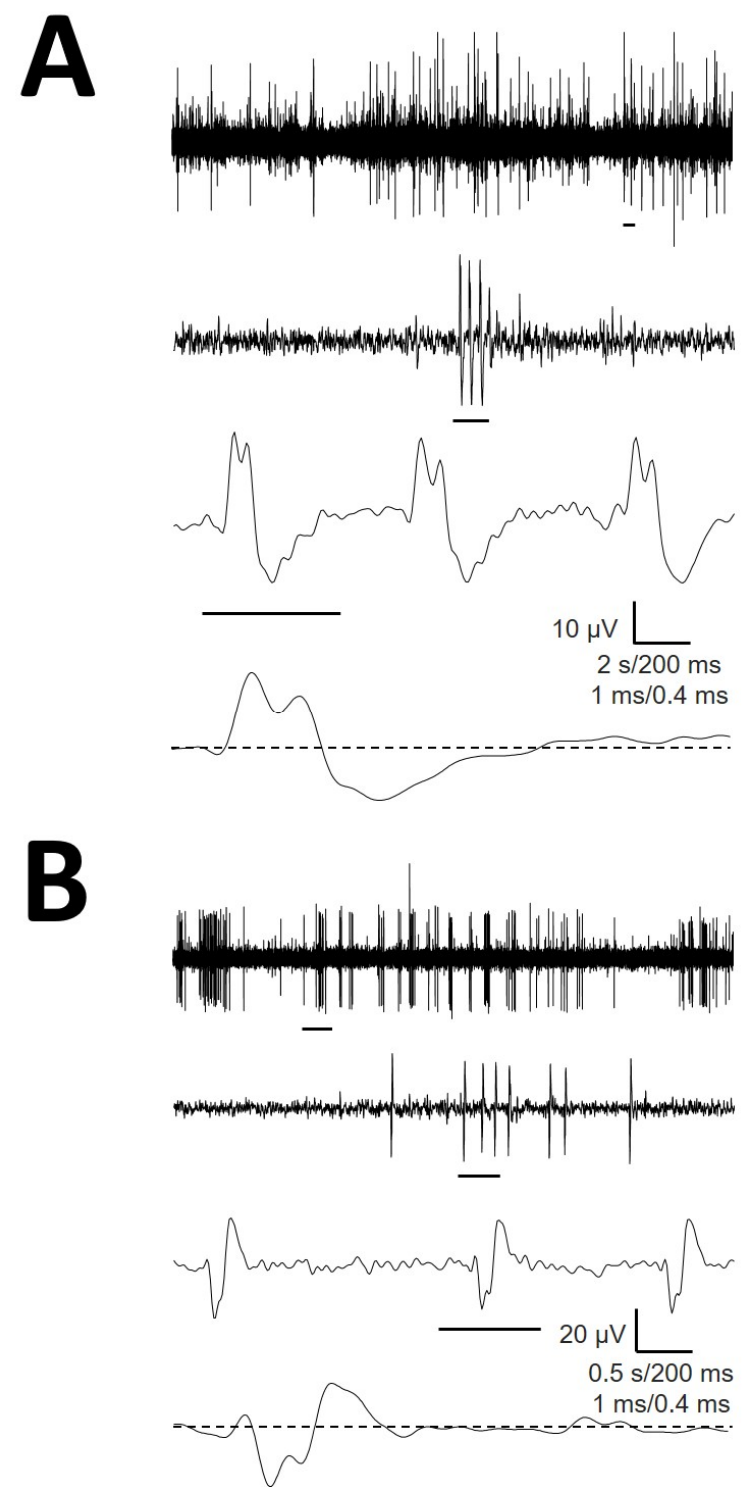
Figure 4. Atypical EAP obtained from raw recordings from ( A ) patients #1 ( B ) and #3. A small horizontal line under each trace is expanded in the trace immediately below. Values for horizontal calibration bars correspond to upper to lower traces.